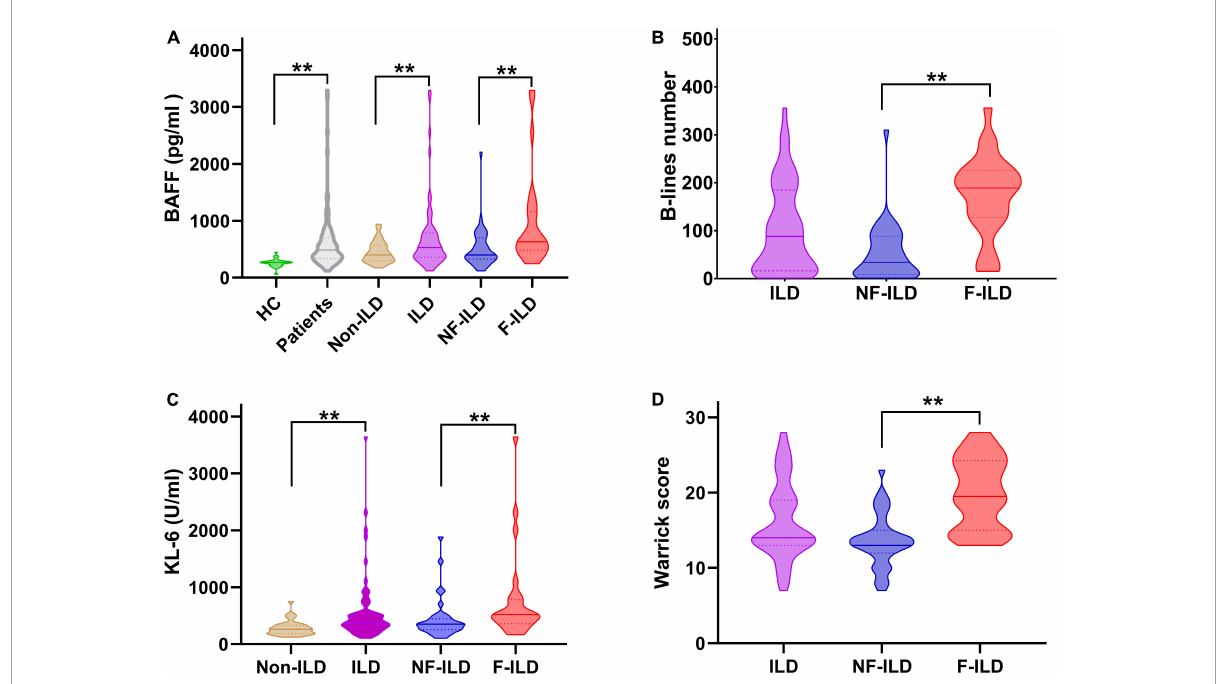
FIGURE1 Distribution of serum (A) BAFF (pg/ml) and (C) KL-6 (U/ml) levels, (B) B-lines number, and (D) HRCT Warrick score in different groups. BAFF, B-cell activating factor; F-ILD, fibrotic interstitial lung disease; HC, healthy control; HRCT, high resolution computed tomography; ILD, interstitial lung disease; KL-6, Krebs von den Lungen-6 Antigen; NF-ILD, non-fibrotic interstitial lung disease. ** P <